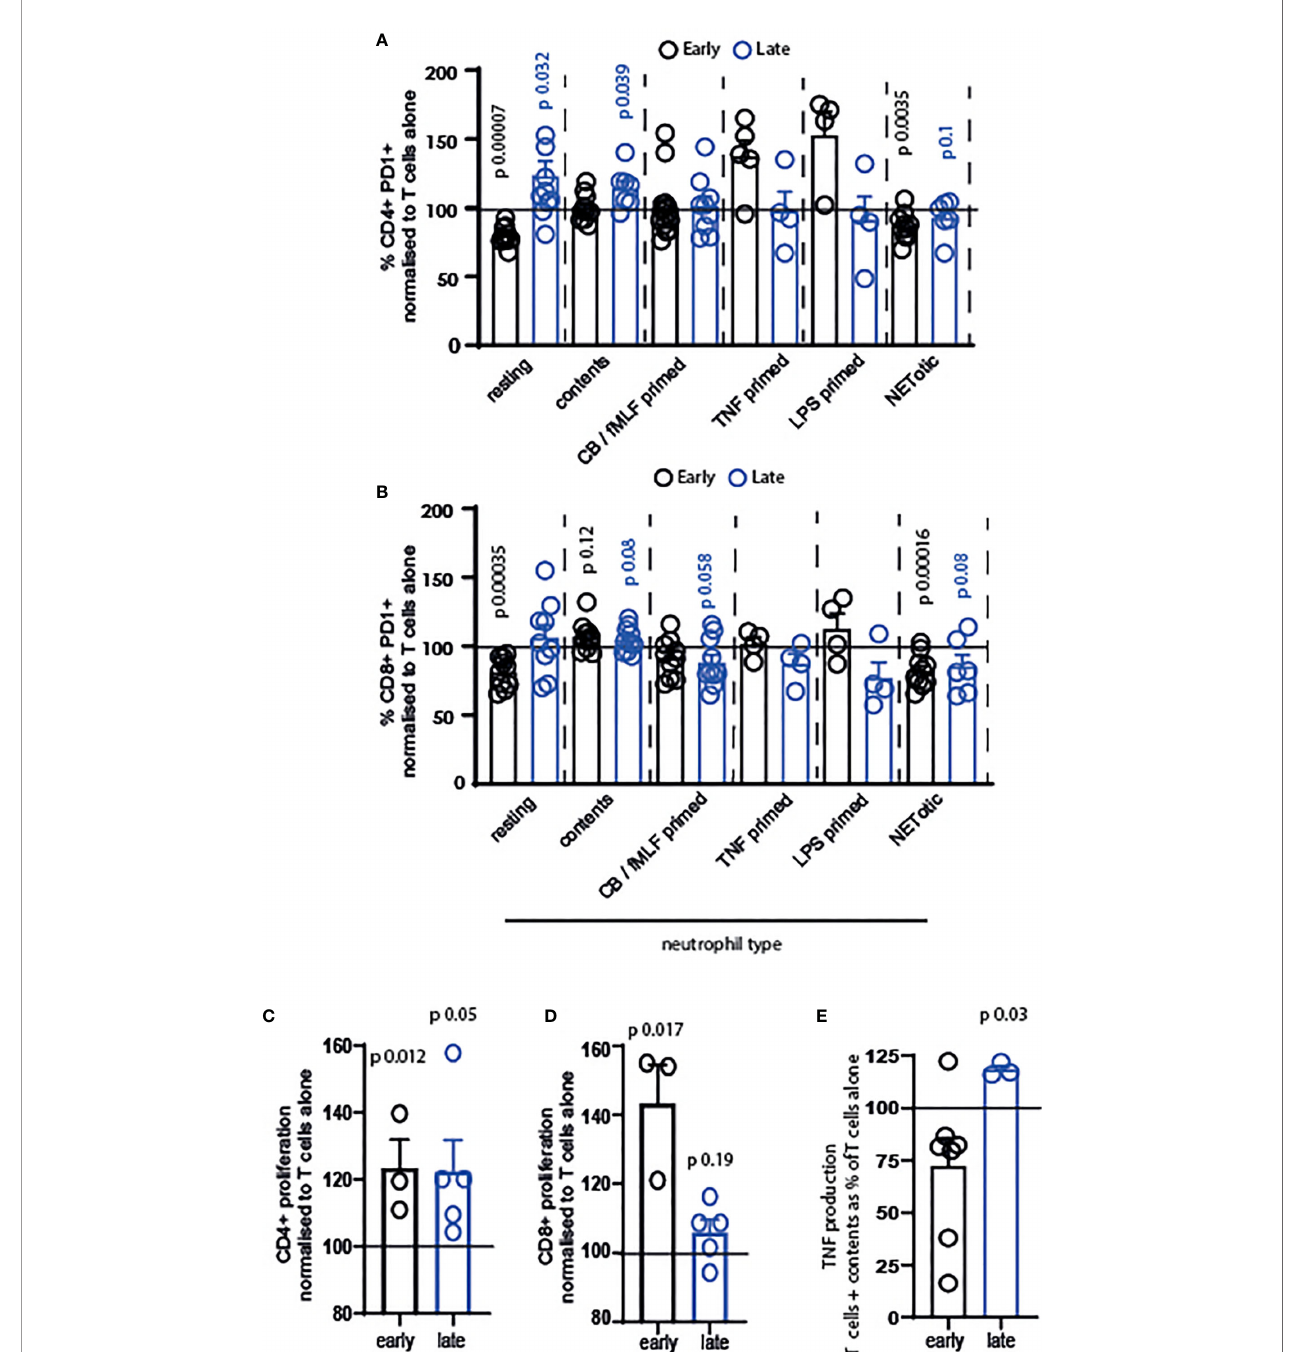
FIGURE 3 | Resting and primed neutrophils, and their contents, differentially affect T cells. T cells and neutrophils were isolated from peripheral blood of healthy human donors using negative magnetic separation, and were cultured together at a 5:1 neutrophil: T cell ratio. Activation of (A) CD4+ and (B) CD8+ T cells following 24 hours co-culture with neutrophils was assessed via quanti fi cation of PD1 expression by fl ow cytometry. Proliferation of (C) CD4+ and (D) CD8+ T cells was assessed following 72 hours co-culture with contents released from neutrophils during lysing. (E) Following 24 hours culture of T cells with released contents, culture supernatant was collected and TNF measured by ELISA. In all cases black symbols = early activating T cells, blue symbols = late activating T cells. N values of individual donors, each of which was plated separately: (A) resting 10 early 10 late; contents 10 early 7 late; CB FMLF 14 early 9 late; TNF 5 early 4 late; LPS 4 early 4 late; NETotic 10 early 6 late. (B) resting 10 early 9 late; contents 10 early 7 late; CB FMLF 10 early 11 late; TNF 4 early 4 late; LPS 4 early 4 late; NETotic 10 early 6 late. (C) 3 early 5 late; (D) 3 early 5 late; (E) 7 early 3 late. Data between T cells exposed to neutrophils and control T cells were analyzed by paired t tests on raw data before conversion to percentages. CB/FMLF = primed with cytochalasin B and